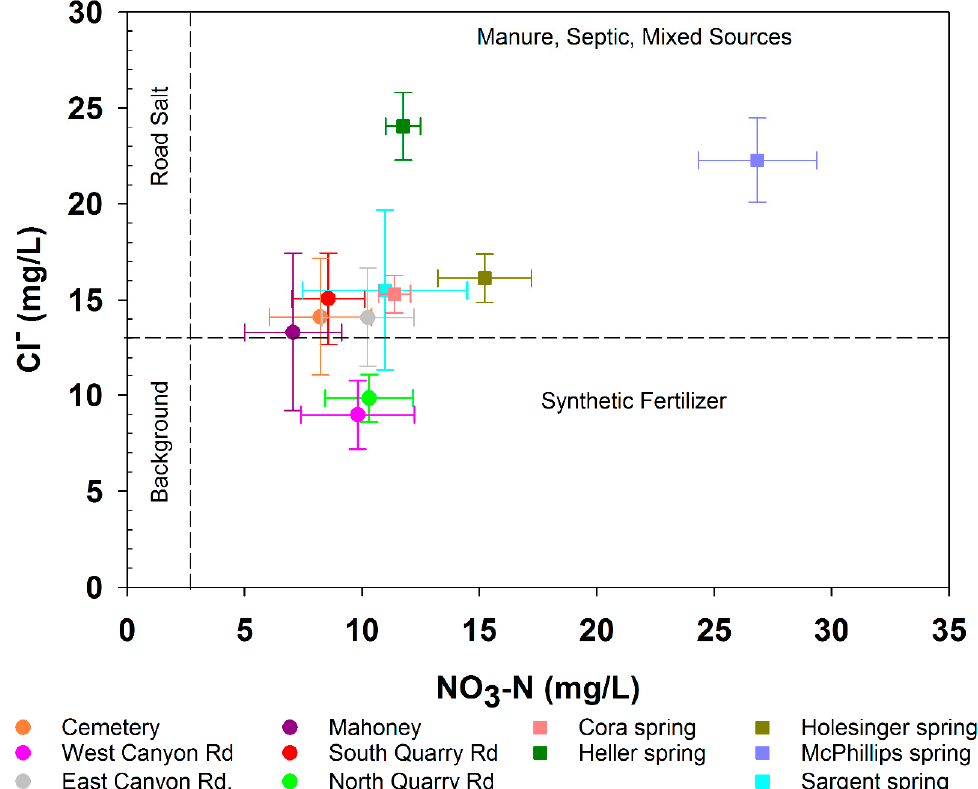
Figure 7. NO 3 -N versus Cl − for the stream waters (circles) and spring waters (squares). Dashed lines represent background values [26,70] . Classifications defined by Taylor, et al. [59] .